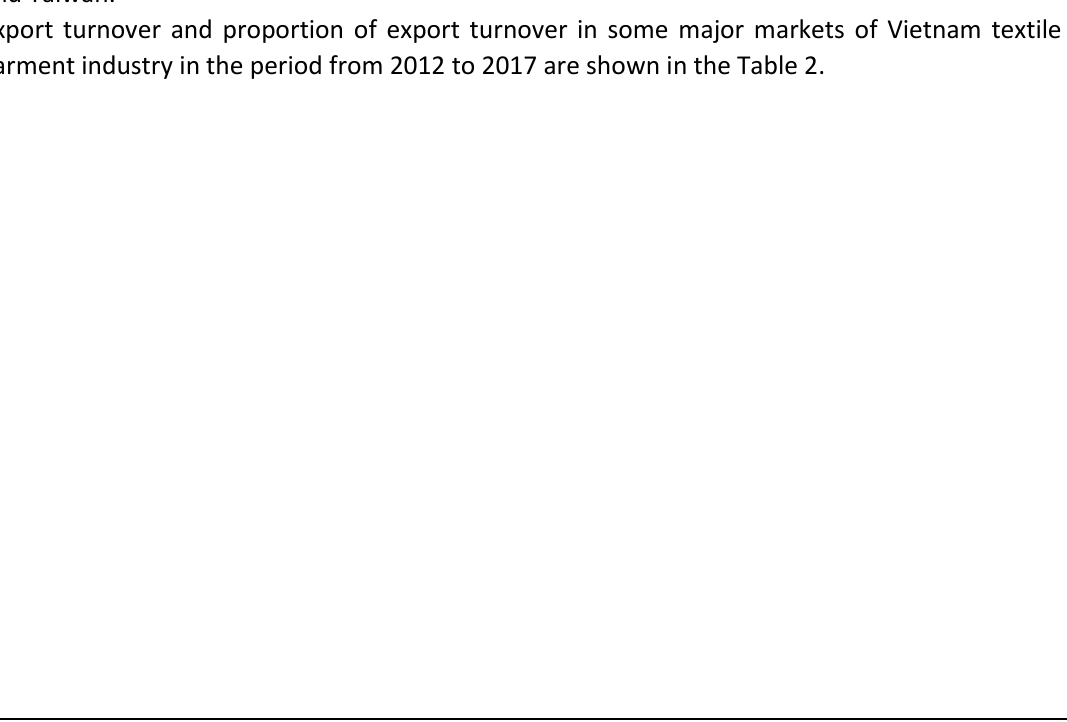
Table 1. Index of industrial production and exports of Vietnam textile and garment (2012 to 2017).